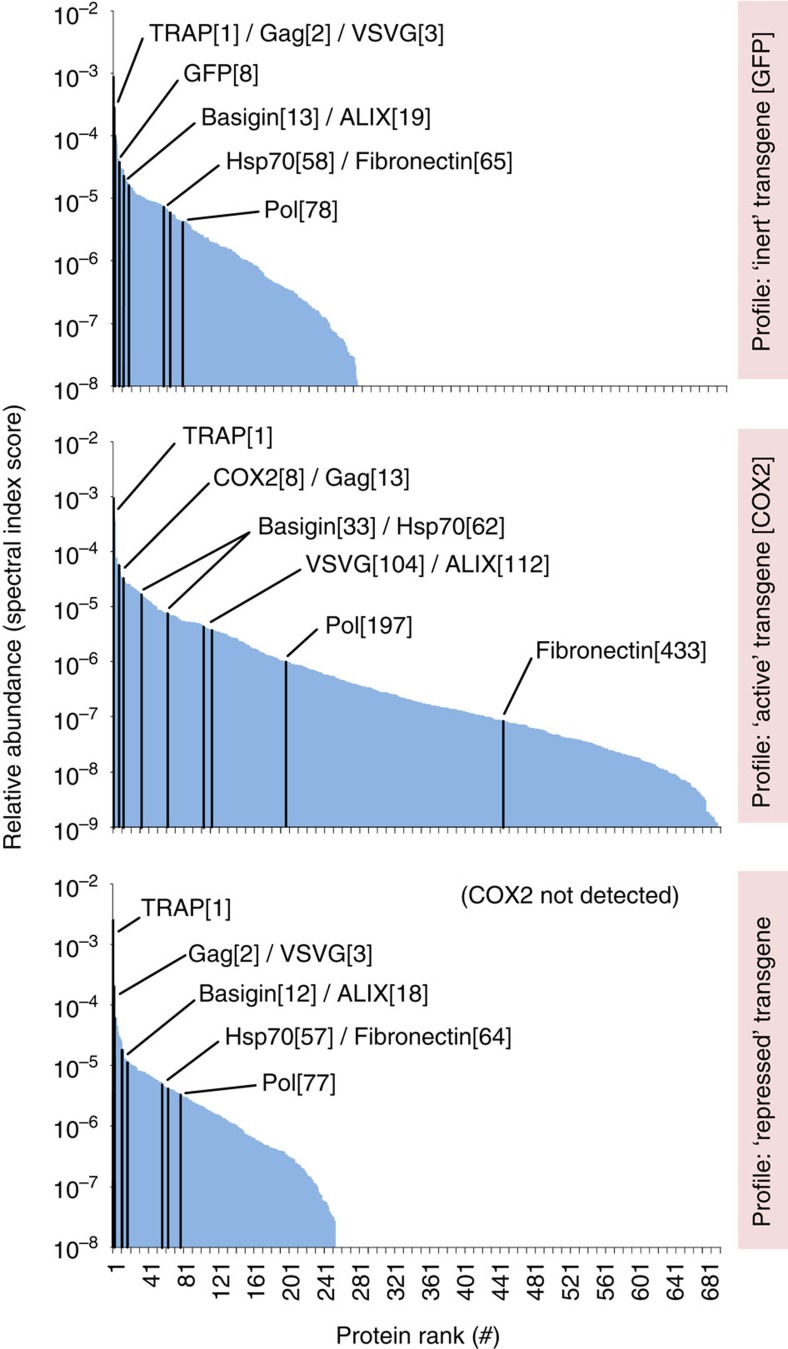
Protein profiles of serum-free EIAV-CMV-GFP, EIAV-CMV-COX2 and EIAV-CMV-tbsCOX2 vector preparations made in the presence of TRAP.Quadruplicate serum-free vector concentrates were analysed by Mass Spectrometry Spectral Index-Normalized Quantitation (MS-SINQ). The profiles represent hits that varied by less than four-fold between replicate samples. EIAV-CMV-GFP and EIAV-CMV-COX2 represent ‘inert' and ‘active' transgene profiles respectively, compared to the ‘repressed' transgene profile of EIAV-CMV-tbsCOX2. A large number of rare proteins were upregulated in EIAV-CMV-COX2 preparations (making up its profile ‘tail'), and to a lesser extent also in EIAV-GFP. Changes within the top ∼150 proteins (∼90% of total detected) in EIAV-CMV-COX2 were less pronounced, with the exception of Gag, VSV-G and Fibronectin, which were reduced and appeared at lowing rankings. Common hits were used in three-way comparison of peptide pools of quadruplicates of each vector type, summarized in Table 1.